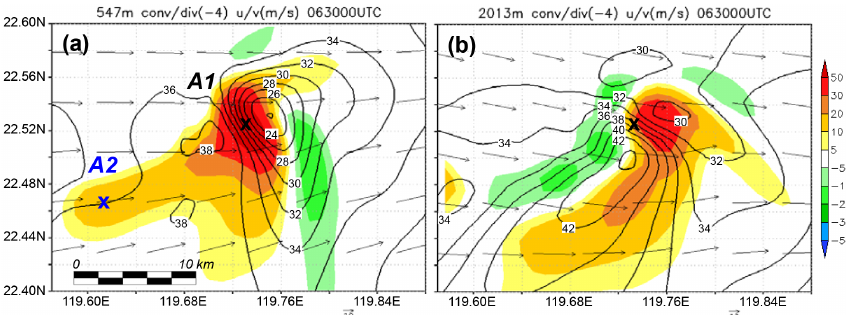
Figure 9. Model-simulated horizontal winds (ms − 1 , vectors, reference vector at bottom), wind speed (contours, intervals: 2ms − 1 ) , and convergence/divergence (10 − 4 s − 1 , color, positive for convergence, scales on the right) at (a) 547m (fourth output level) and (b) 2013m (ninth output level) associated with the convective cell “A1” off the southwestern coast of Taiwan at 06:30UTC, 8 August 2009. The “x” marks the updraft center at 1058m (cf. Fig.